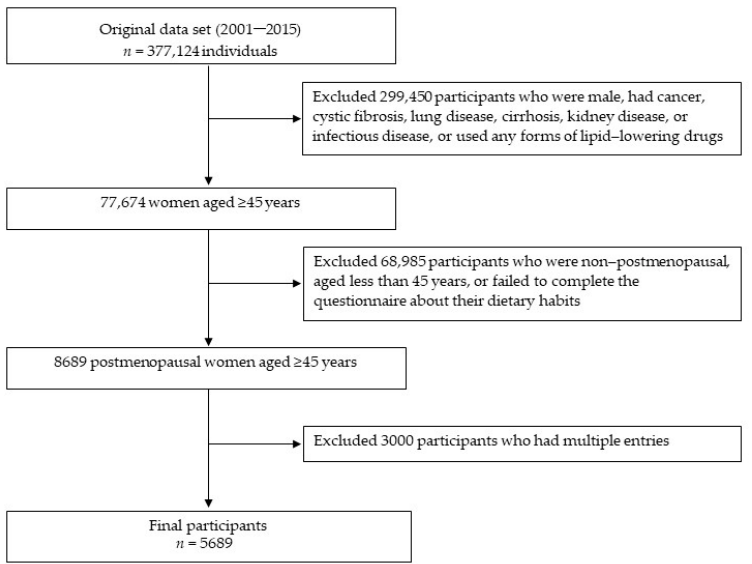
Figure 1. Flowchart of study participants.